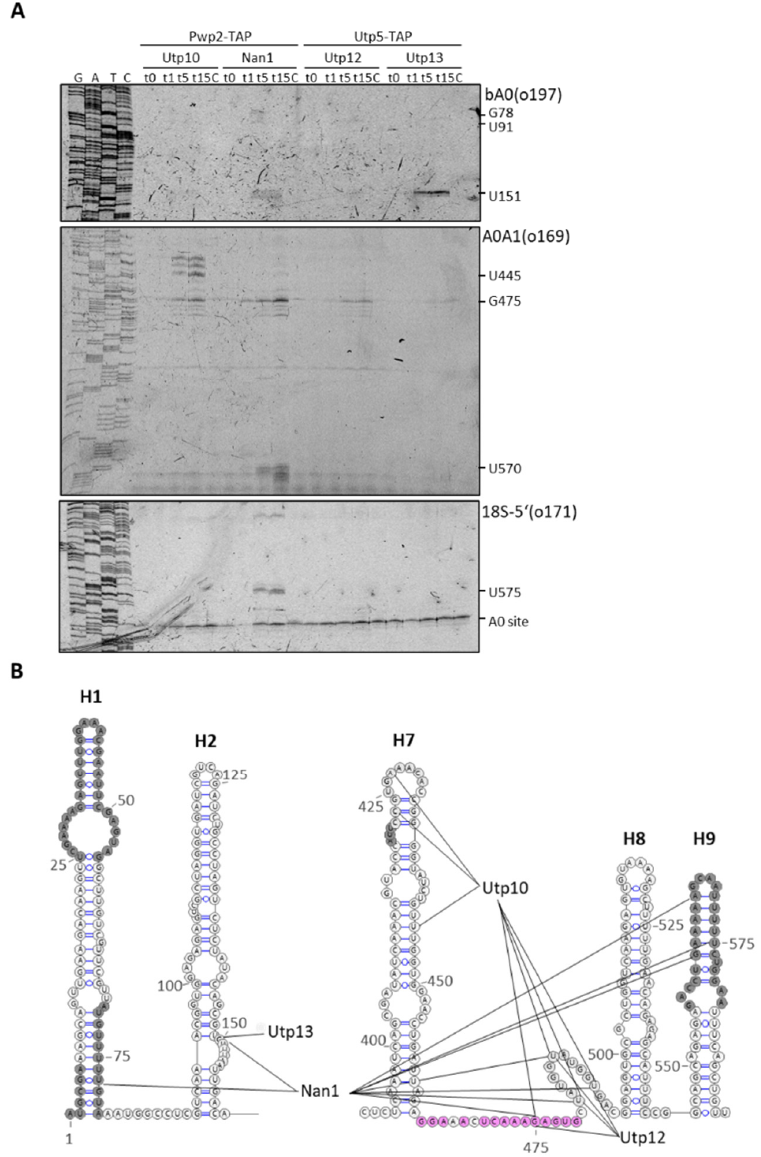
Figure 3. Characterization of RNA fragments obtained in the 5 ′ ETS region after MNase treatment. Purified particles were incubated in the presence of CaCl 2 for 10 min, and RNA fragments were obtained by hot phenol extraction and used for primer extension analysis with fluorescent oligonu- cleotides. ( A ) The 5 ′ ETS region was explored using oligonucleotide base pairing in the 5 ′ ETS (upper and middle panels) or the 5 ′ end of 18S rRNA (lower panel). ( B ) Stops in the reverse transcription observed in A and B were plotted in the schematic representation of the 5 ′ ETS region (according to [22] ). Components of the UTP complexes fused to TAP and MNase are indicated on top, and probes used for primer extension are indicated at the top right of the panels. Some nucleotides at prominent stops are indicated on the right side. Shaded nucleotides correspond to unresolved regions in pub- lished structures. Pink nucleotides correspond to the base-pairing site between helix 1b of the U3 snoRNA and the 5 ′ ETS.